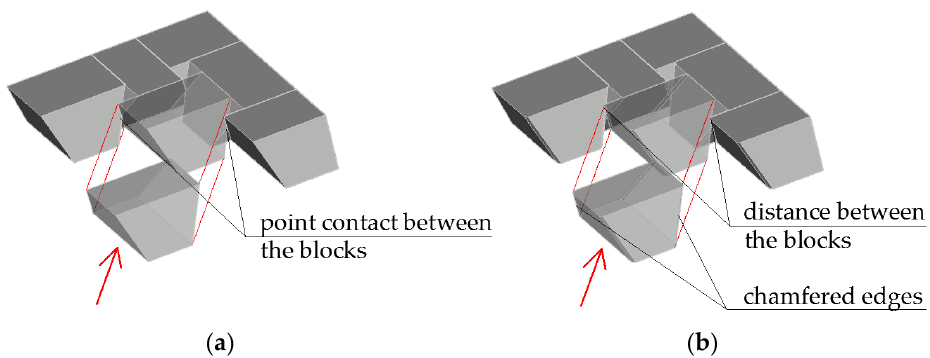
Figure 24. Sliding the components into place in a both sides rugged vault: ( a ) a components with non-chamfered edges; and ( b ) components with chamfered edges.